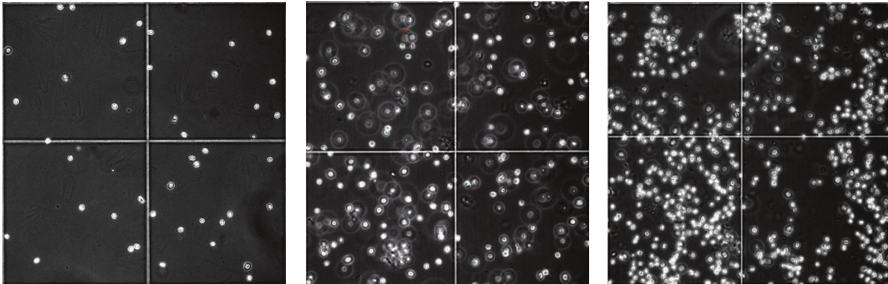
Figure 6: Scenedesmus sp. culture in absence of 232 Th at pH 6.0 (left); in absence of 232 Th at the 7th day of growth (center); in the 23rd day of growth (right) (20-fold